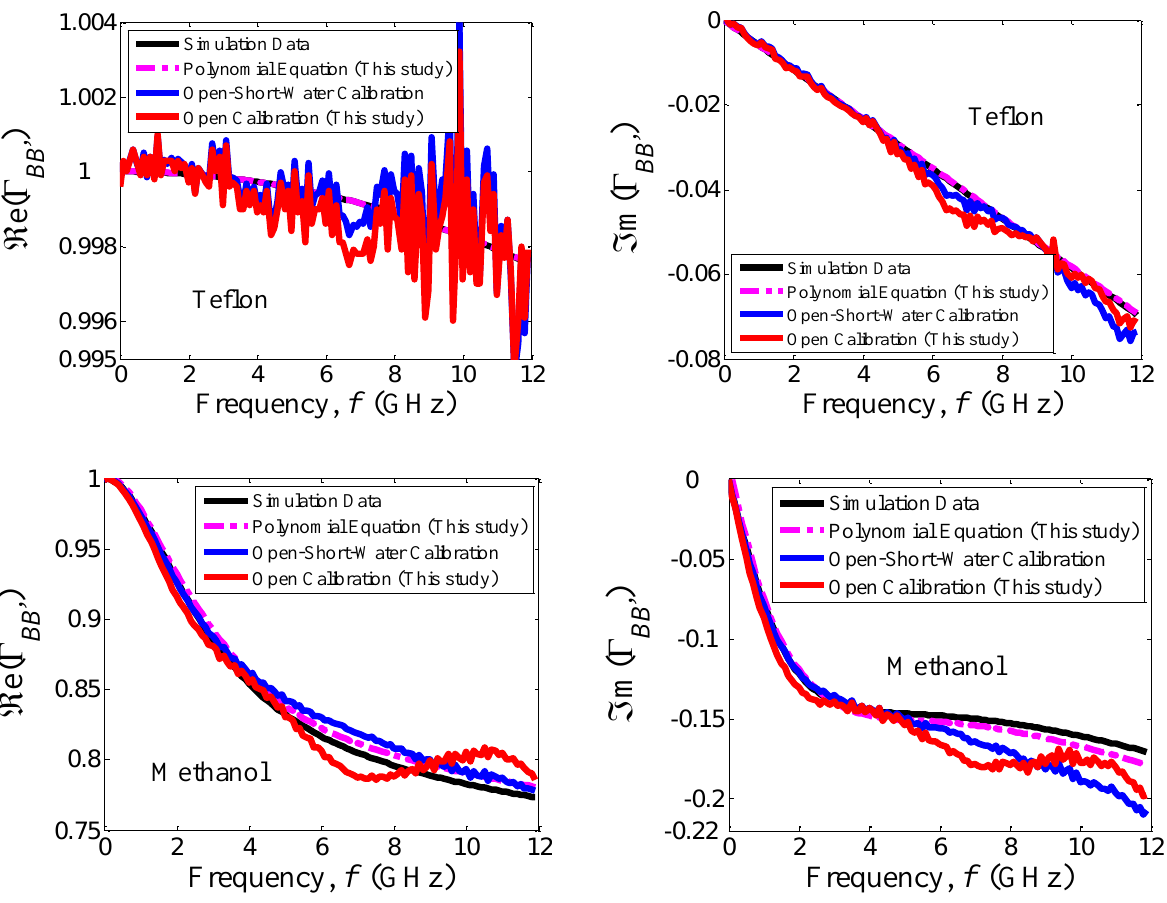
Figure 3. Variation in real and imaginary parts of reflection coefficient, ( Re (Γ (Γ )) at plane BB’ with frequency, f at (25 ± 1) BB’